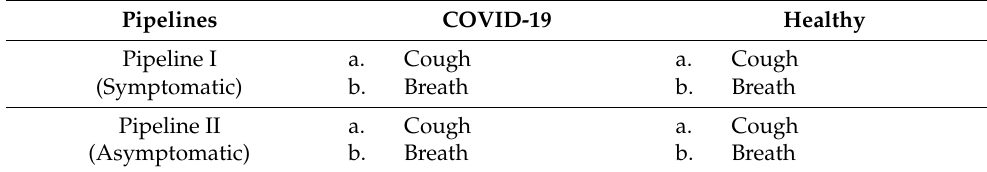
Table 2. Experimental pipelines for this